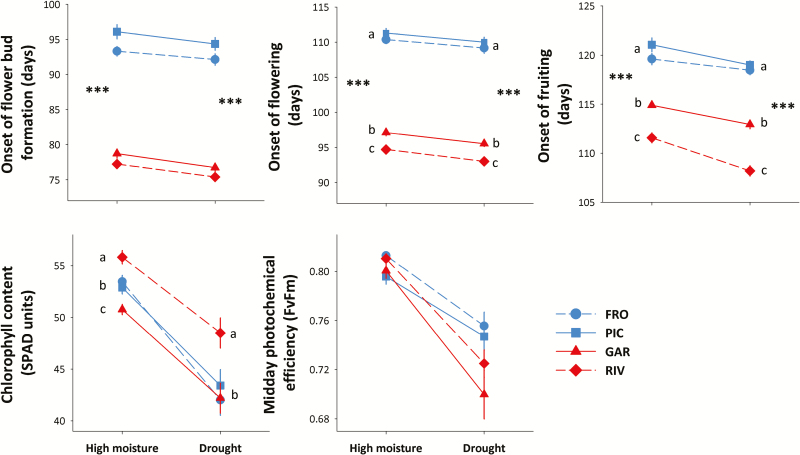
Population differences in phenological and physiological traits in two contrasting water availability treatments. Each line shows the norm of reaction of each of two northern (blue) and two southern (red) populations for a given trait. Observed population means ± SE are shown for 21 families per population, with three replicates per family and treatment. Significant regional differences in each watering treatment are shown with asterisks (no asterisk: not significant differences; **P < 0.01; ***P < 0.001). Different letters indicate significant differences among populations in mean trait values within each watering treatment, according to Tukey post hoc tests. The presence of both asterisks and letter indicates significant differentiation between regions and populations within regions. N = 504 plants for all traits. Population codes are those in Fig. 1.